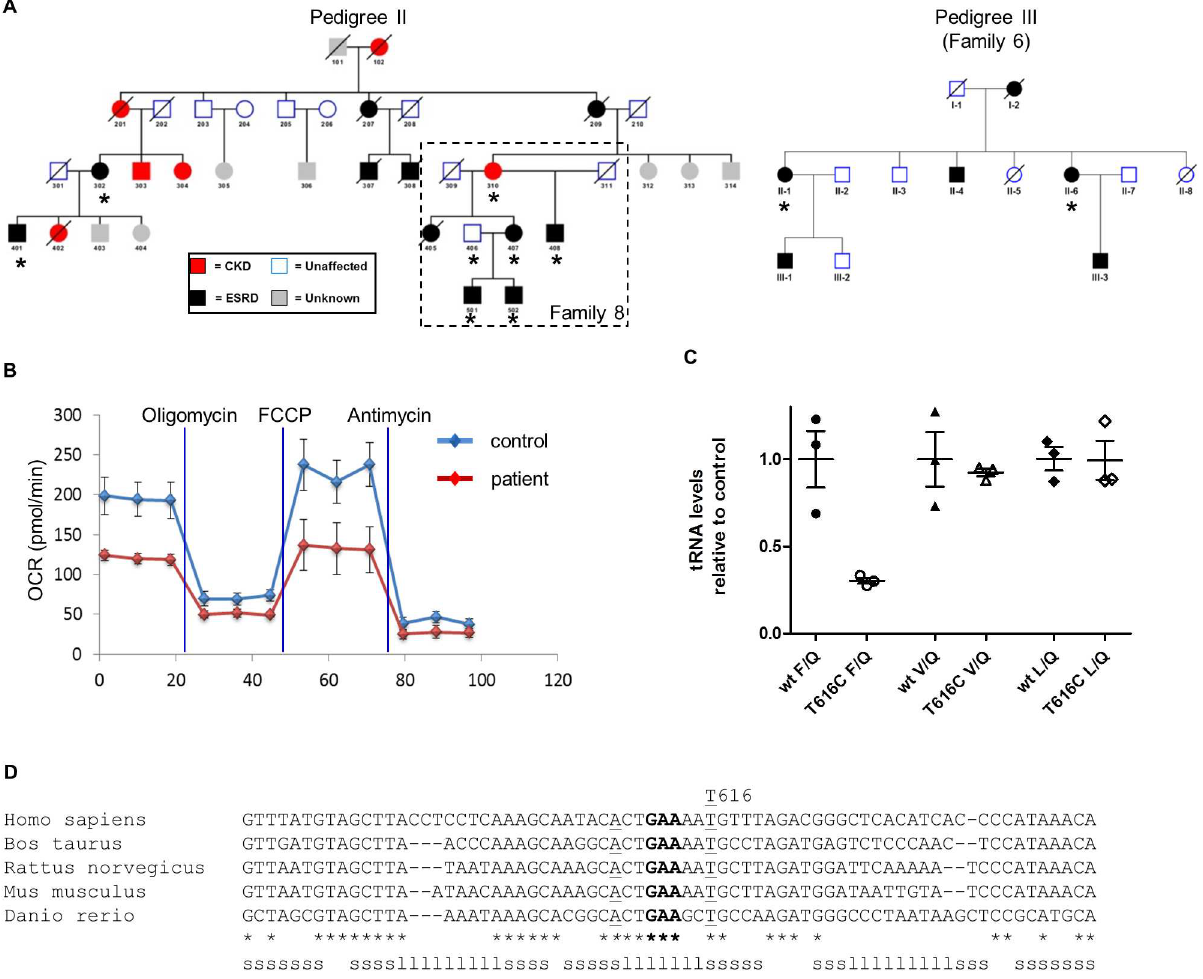
Fig 6. mt.616T > Ccybrids have a defect in respiration. (A) Twopedigreesshowingpotentialmaternalinheritanceof renaldisease.Individ- ualswithkidneydiseasearerepresentedbyfilledshapesasin Fig 1.Family8 from ref 13 formspart of pedigreeII, andis indicatedbythe dotted box.PedigreeIII is Family6 from ref 13.Individualsfrom whomDNAwassequenced in thecurrentstudyaremarkedwithasterisks. All affected individualswhoweresequencedwerefoundto havehomoplasmiclevelsof the m.616T > C substitution. The mitochondrialhaplotypeis T1a1. (B) Measurement of oxygenconsumptioninpatient-derived andcontrolcybridsshowinga reductionin basal(beforeadditionof oligomycin)and maximalrespiration(after additionof FCCP)in patient-derivedcybrids.(C) Expressionlevelsof tRNAsquantifiedbyNorthernblotof threecontrol andpatient-derivedcybridsshowreducedmitochondrialtRNAPhelevelsrelativeto the lightstrandencodedtRNAGlnin mt.616T > C cells. (p = 0.006)ThetRNAlevelsfor valineandleucinewereunaffected. (D) Conservationof mt tRNAPhewithinvertebrates. The anticodon (GAA) is highlightedinbold,thenucleotidesformingthe lastpairof the anticodonstem areunderlined. Sequenceswerealignedwithclustalomegaand manuallyadjusted.The stem(s) andloop(l) secondary structureof the tRNAPheof humansis indicatedat the bottom.